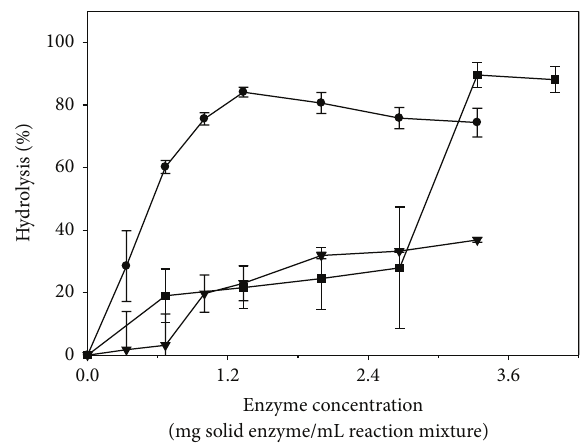
Figure 2: Effect of enzyme concentration, using lipases from Candida rugosa type VII (CRL) ( e ), porcine pancreas type II (PPL) ( 󳶃 ), and Thermomyces lanuginosus (Lipozyme TL IM) ( ◼ ), on the hydrolysis of 6 mM safflower oil.